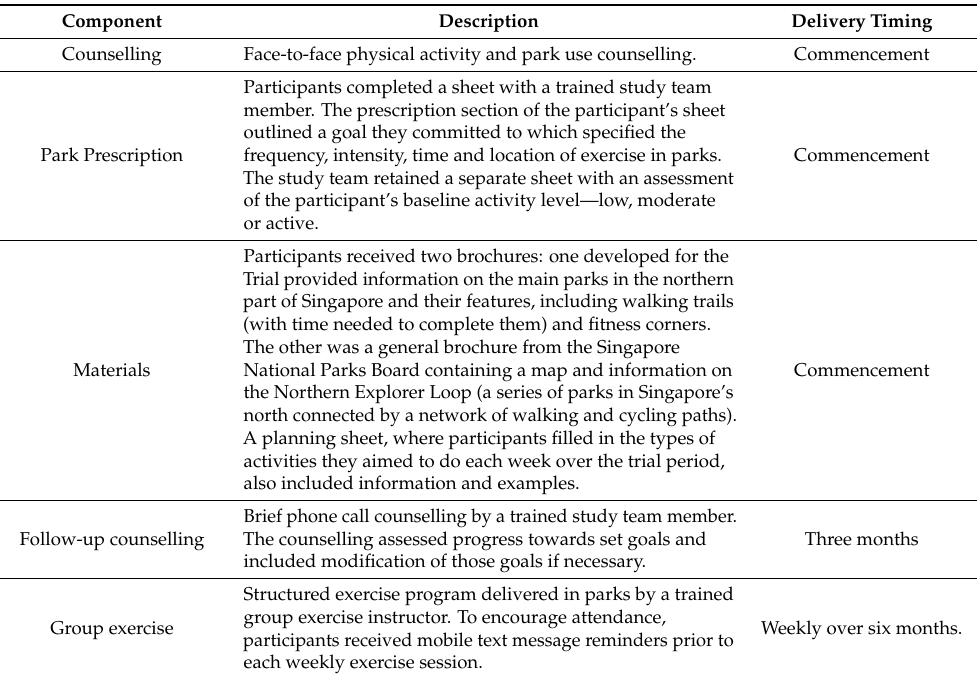
Table 1. Intervention components and intervention delivery